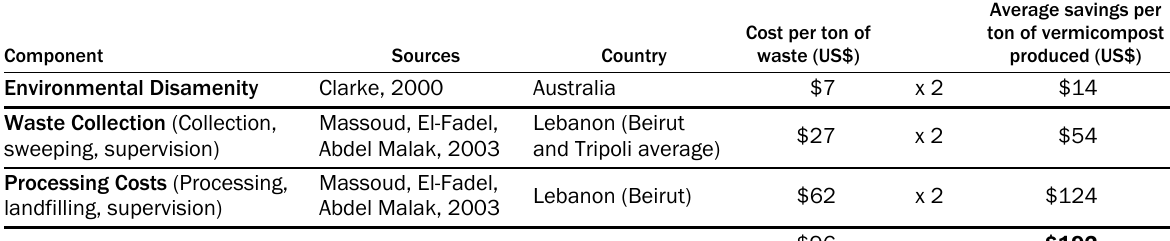
Table 3. Calculating the Waste Management Benefits of Using Vermicast